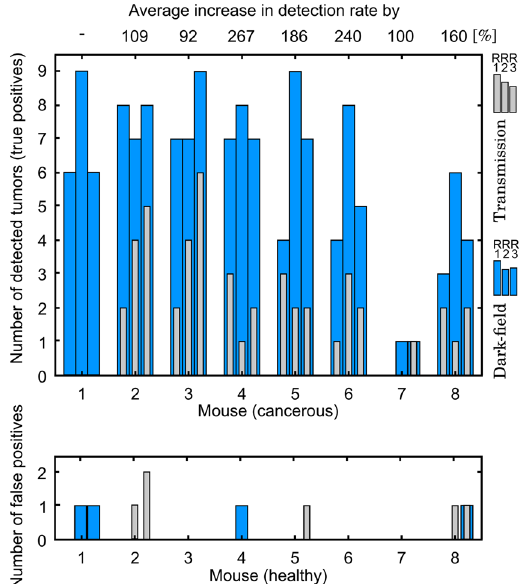
Figure 3. Reader study: transmission versus dark-field radiography in-vivo . Based on the transmission and dark-field radiograms, three experienced and blinded radiologists were asked to assess the number of radiopaque tumors in 16 mice (8 tumor-bearing, 8 healthy). A significant improvement in detection rate (true- positives) was found, when exploiting scatter-sensitive dark-field imaging, ranging from an average increase by 92% up to a maximum increase of 267%. Based on the control group our analysis provided evidence, that dark- field radiography additionally enhances diagnostic specificity, by reducing the number of false-positives from an overall of 6 to 4